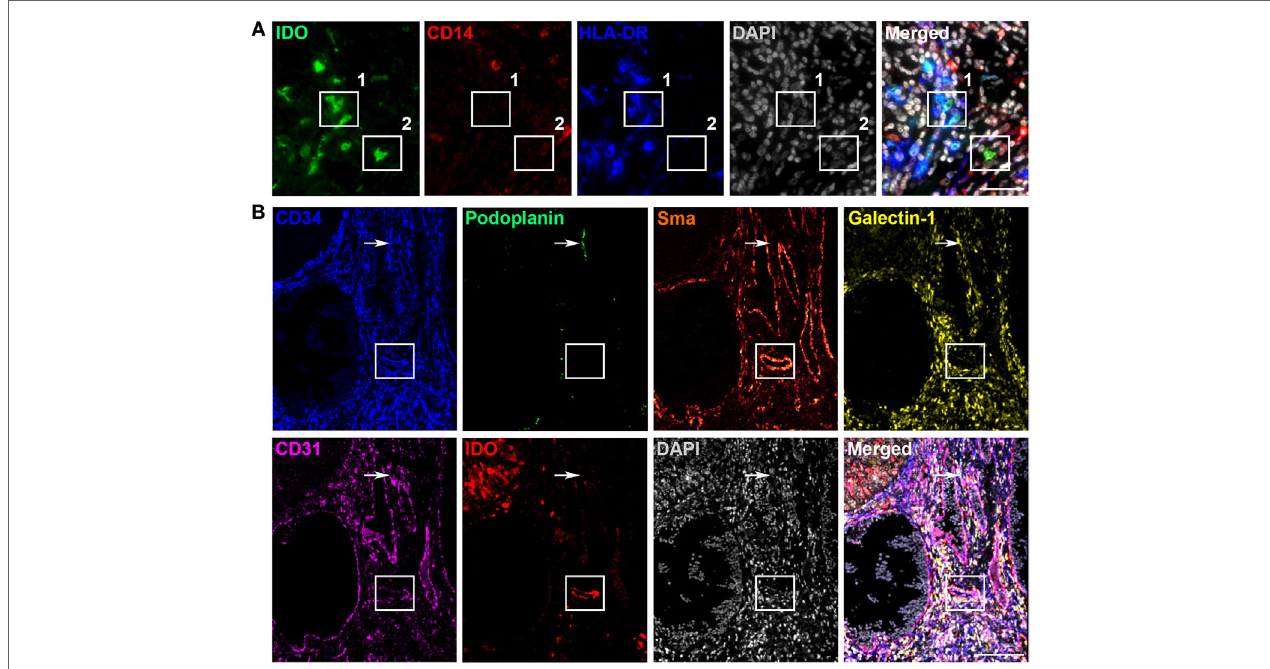
FigUre 2 | Characterization of indoleamine 2,3-dioxygenase (IDO)-positive immune cells and tumor-associated vessels in primary cervical cancer. Different immune cells expressing IDO were detected in primary cervical cancer. (a) Representative immunofluorescence images showing monochromatic IDO (in green), CD14 (in red), HLA-DR (in blue), DAPI (in gray), and the merged panel with IDO, CD14, HLA-DR, and DAPI in the stromal compartment. Box 1 shows IDO + CD14 − HLA-DR + cells and box 2 shows an IDO + CD14 − HLA-DR − cell. Scale bar is 100 µm. (b) Representative immunofluorescence tilescan of a IDO-positive tumor showing monochromatic CD34 (in blue), podoplanin (in green), α -sma (in glow), galectin-1 (in yellow), CD31 (in pink), IDO (in red), DAPI (in gray), and the merged image. Box indicates an IDO-positive vessel expressing CD34, α -sma, galectin-1, and CD31. Arrow indicates an IDO-negative podoplanin-positive lymphatic vessel. Scale bar is 95